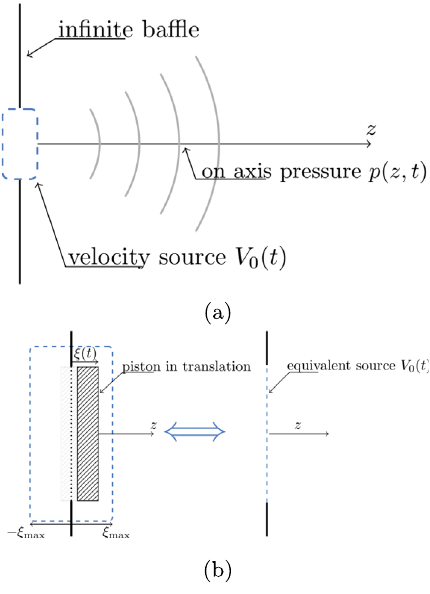
Figure 1. Description of the physical model composed of (a) on-axis baf fl ed piston radiation for the evaluation of the sound pressure and (b) conversion of the piston displacement into an equivalent Eulerian velocity source V 0 ð t Þ